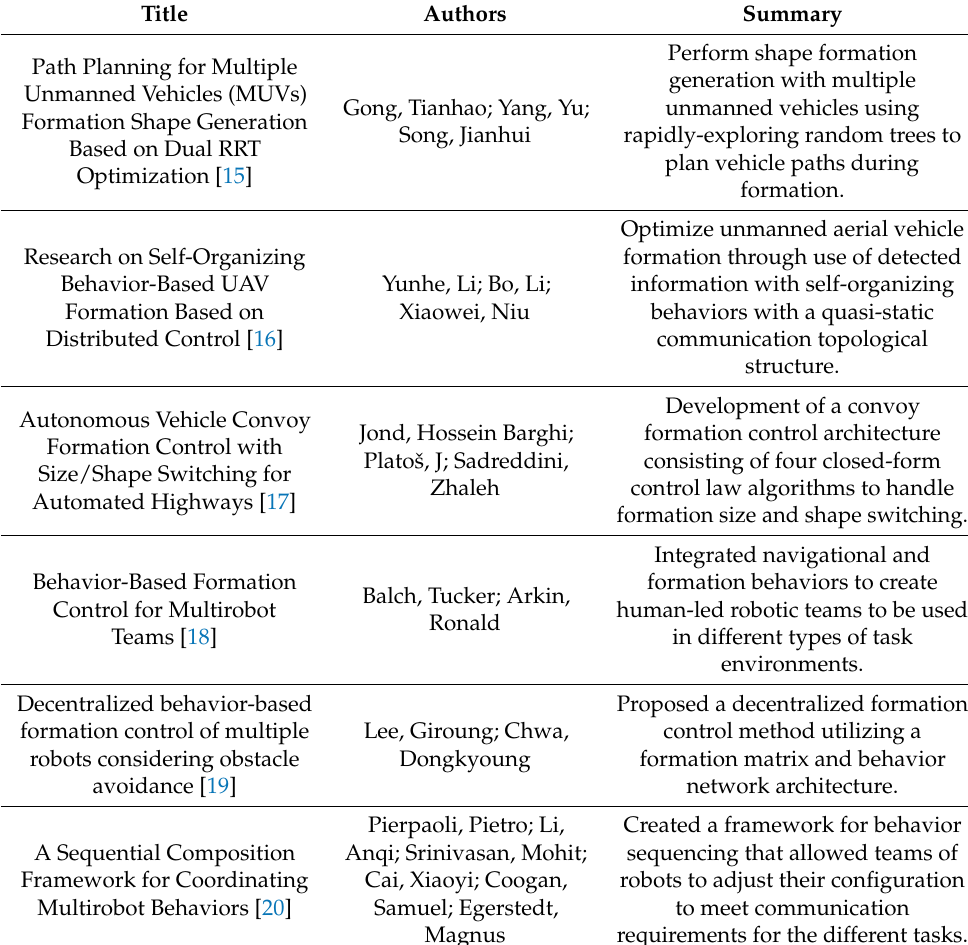
Table 1. Prior work in convoying and formation